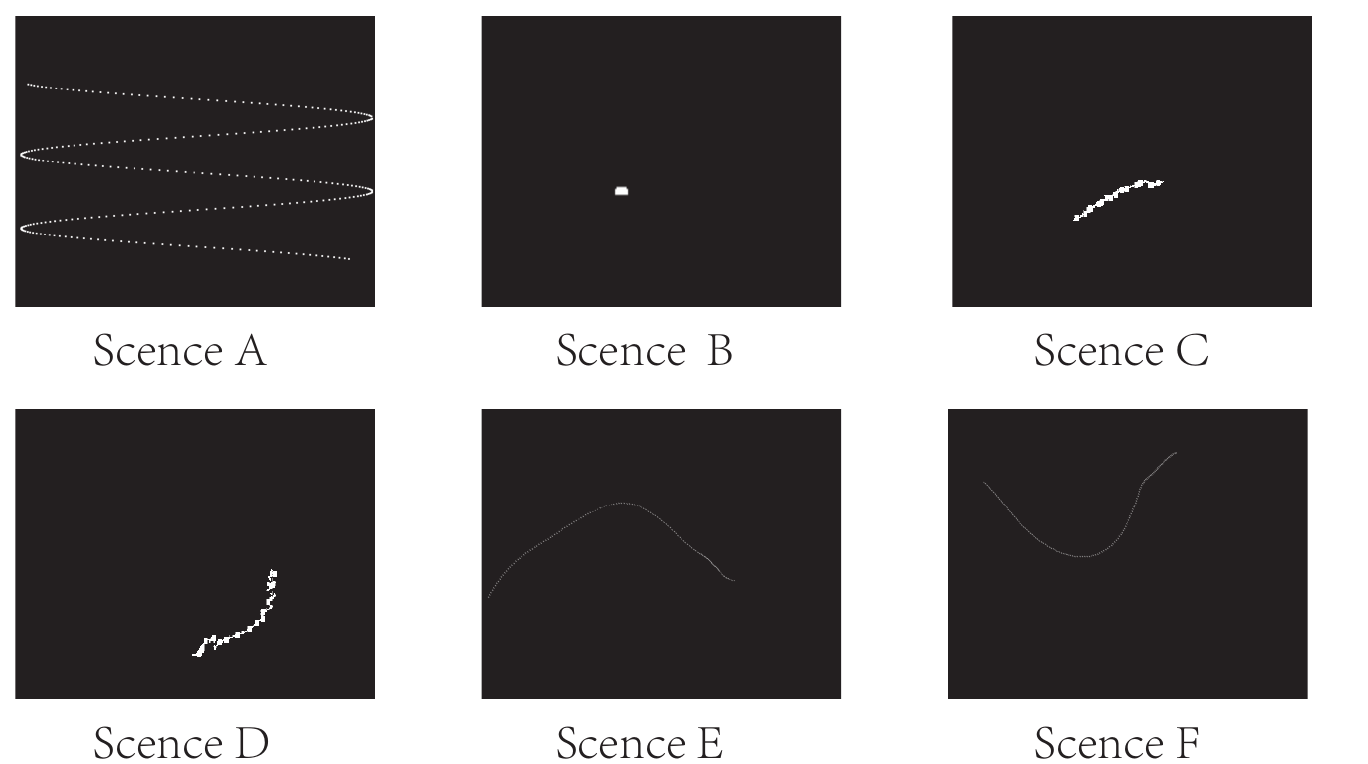
Figure 18. Detection results of the FNPC detection